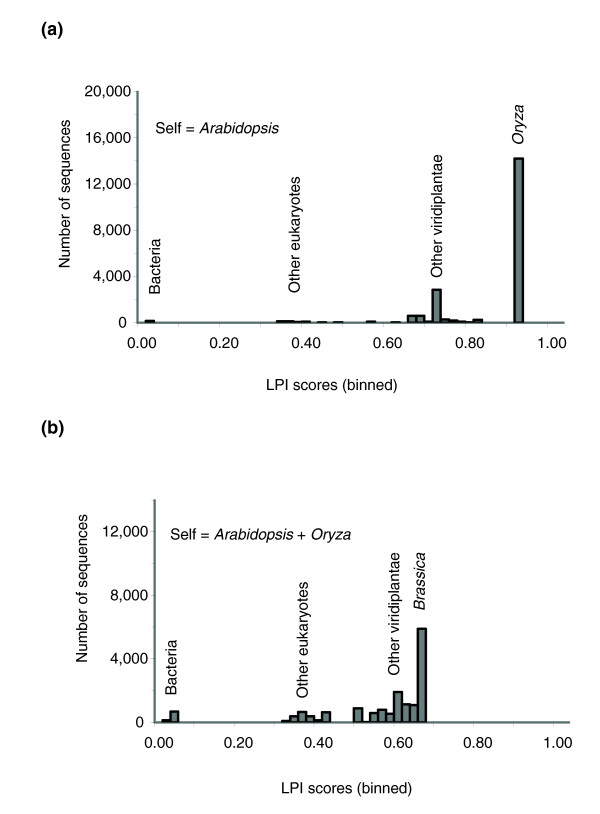
Effect of expanding A. thaliana self definition terms on LPI score distribution histograms. Filter threshold setting was 10%. (a) Self = Arabidopsis. (b) Self = Arabidopsis + Oryza.